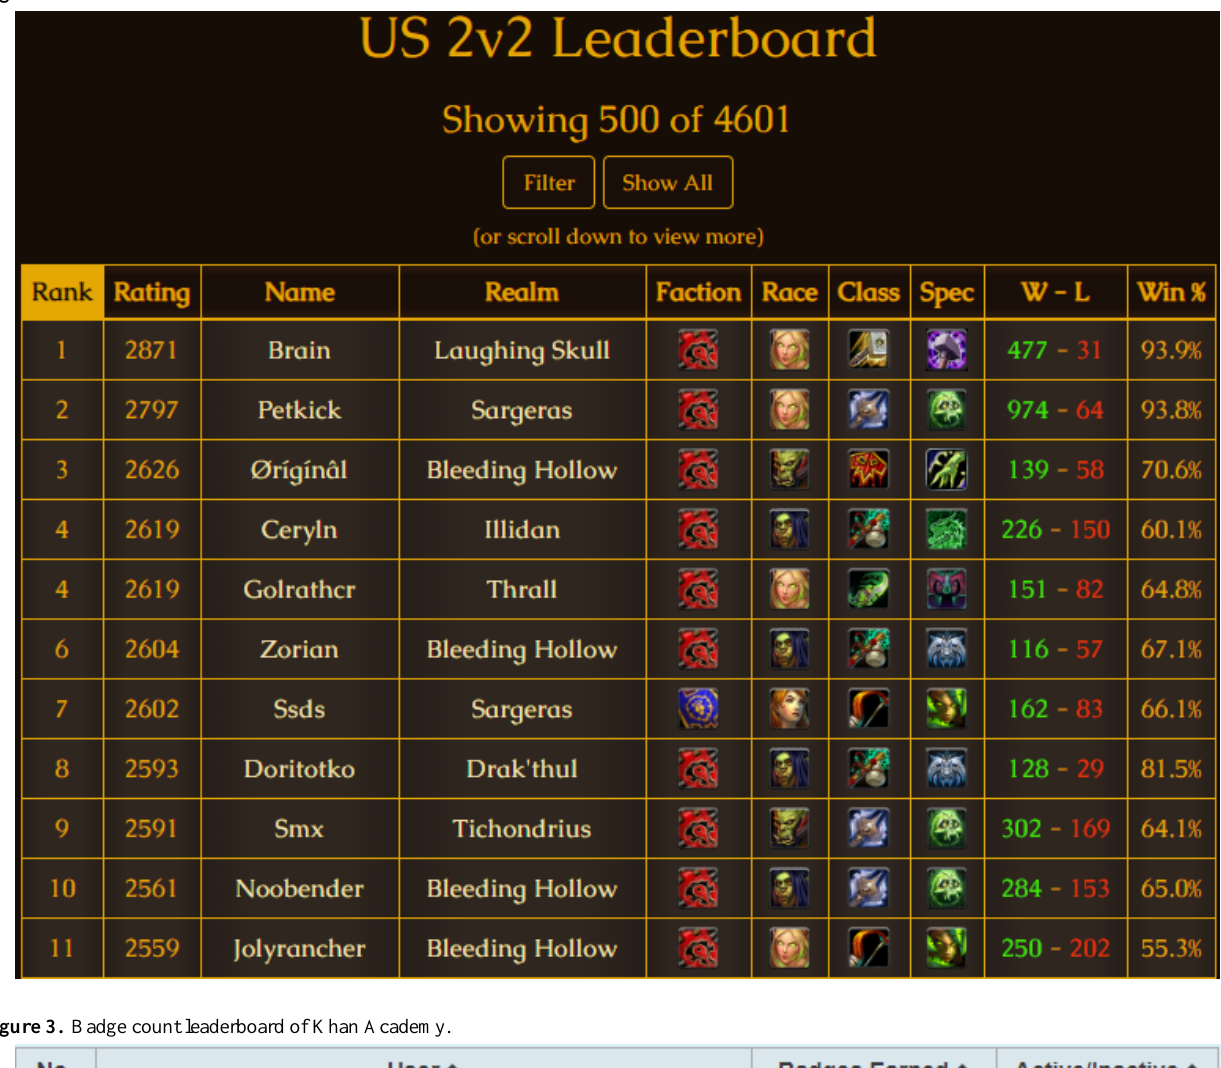
Figure 2. World of Warcraft leaderboard.